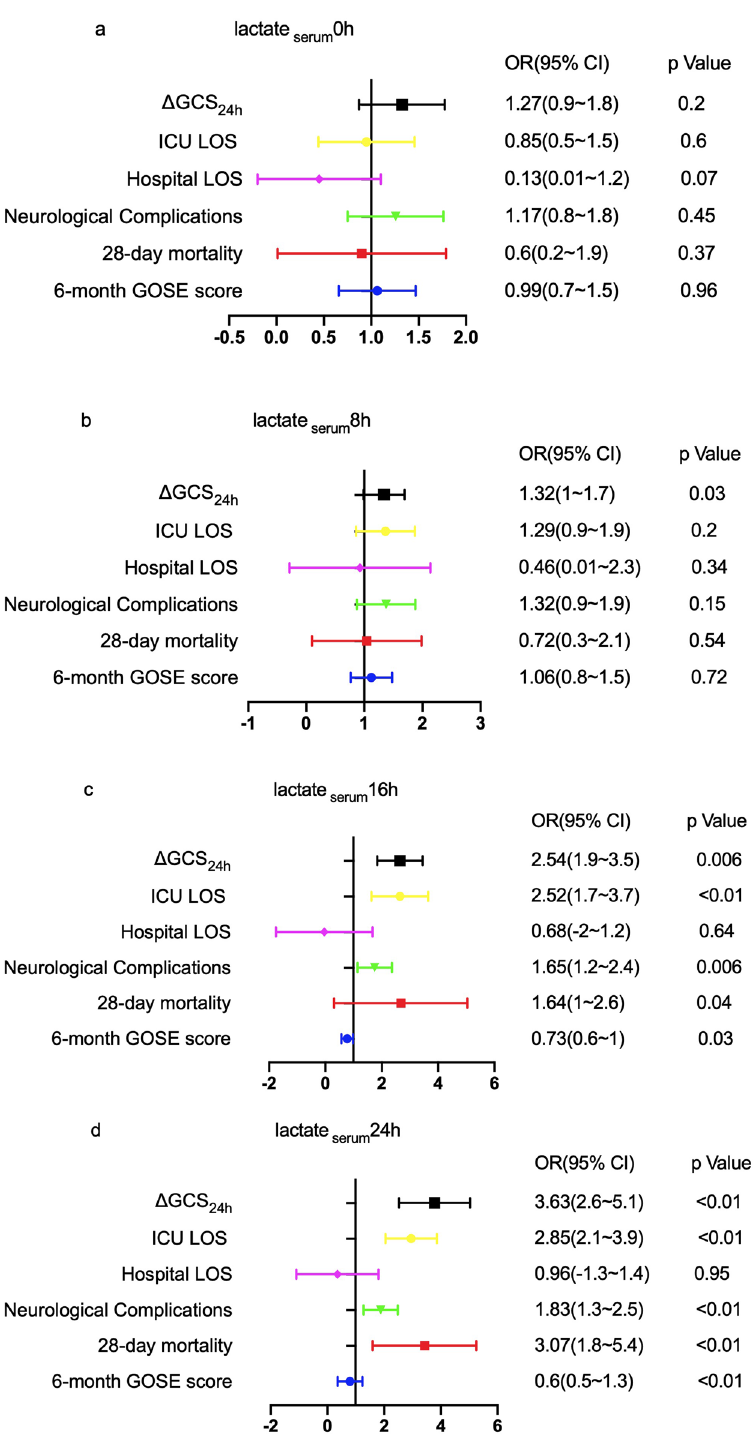
Figure 2. Correlation analysis of the serum lactate and the primary and secondary